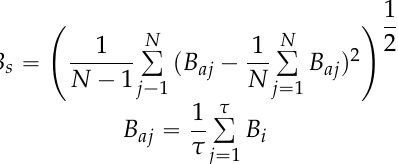
Figure 7. RLG bias compensation model utilizing novel multiple-point temperature gradient algorithm at ( a ) different temperature variation rates; and ( b ) enlarged error curve.